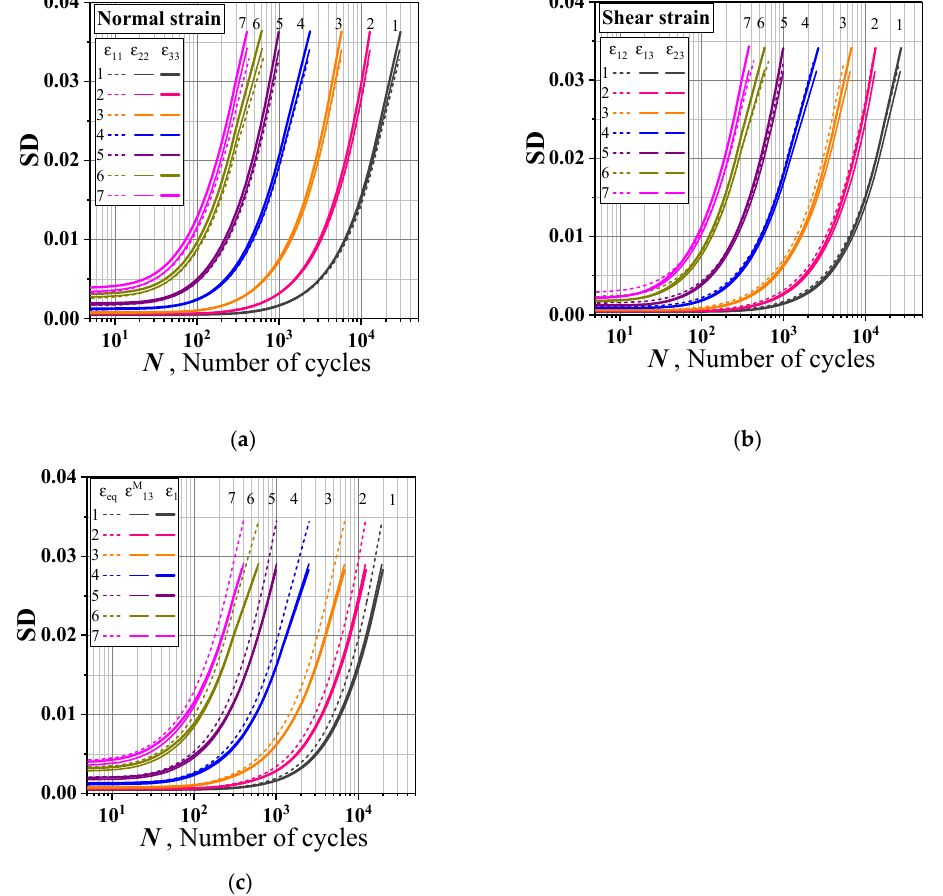
( b ) Figure 6. The curves of differential entropies at different strain amplitude cycle vs. cycle number: ( a ) differential entropies of normal strains,